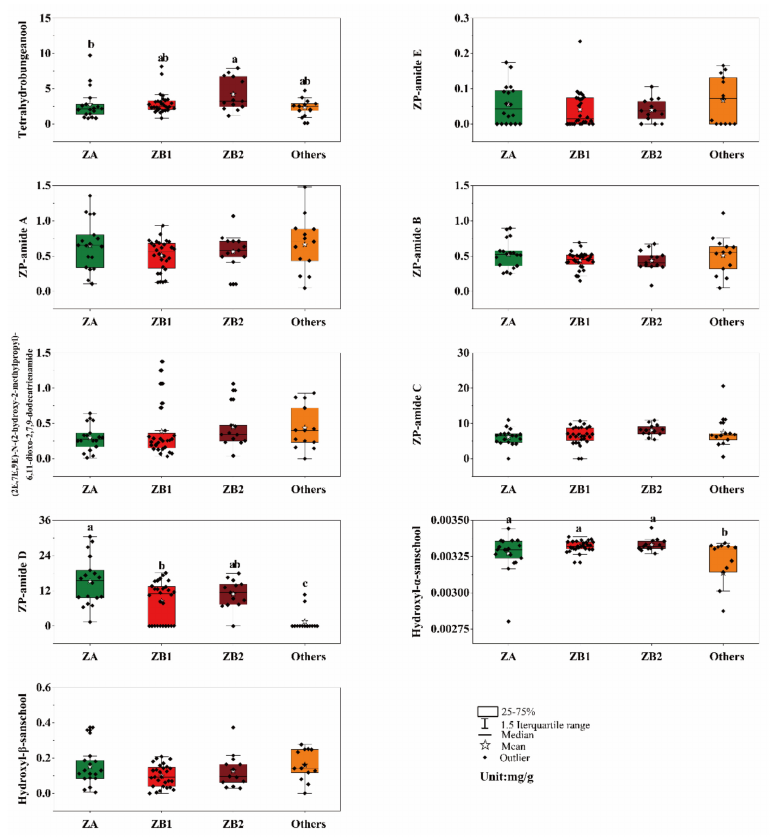
Figure 3. Alkylamide profiling in different prickly ash pericarps. The letters (a, b, c, and ab) above the histogram indicate significant differences among the prickly ash groups using the Student–Newman–Keuls test; the same letters (a or ab) and no letters above the histogram indicate no significant differences among different prickly ash groups ( p < 0.01); the letter “a” indicates the highest content of the compound for the group; ZA represents green pericarps derived from the species of Zanthoxylum armatum ; ZB1 represents red pericarps derived from the species of Z. bungeanum from Hancheng; ZB2 represents red pericarps from Fengxian; and Others includes the rest of the samples that have red pericarps (excluding Z. bungeanum